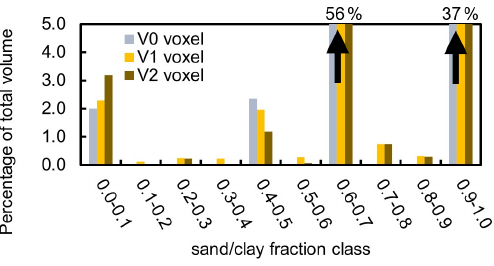
Figure 6. Percentage of the sand/clay fractions of the total volume of the geological voxel models V0, V1, and V2. Note that the sand/- clay fractions 0.6–0.7 and 0.9–1.0, respectively, take up about 37% and 56% in all models and plot beyond the range of the y